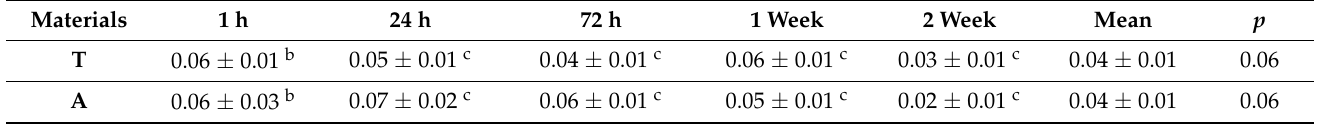
Table 3. The mean and standard deviations of absorbant index level per material in artificial saliva (AS). Different letters a,b,c in the same column indicate significant differences ( p < 0.05). See Table 1 for group